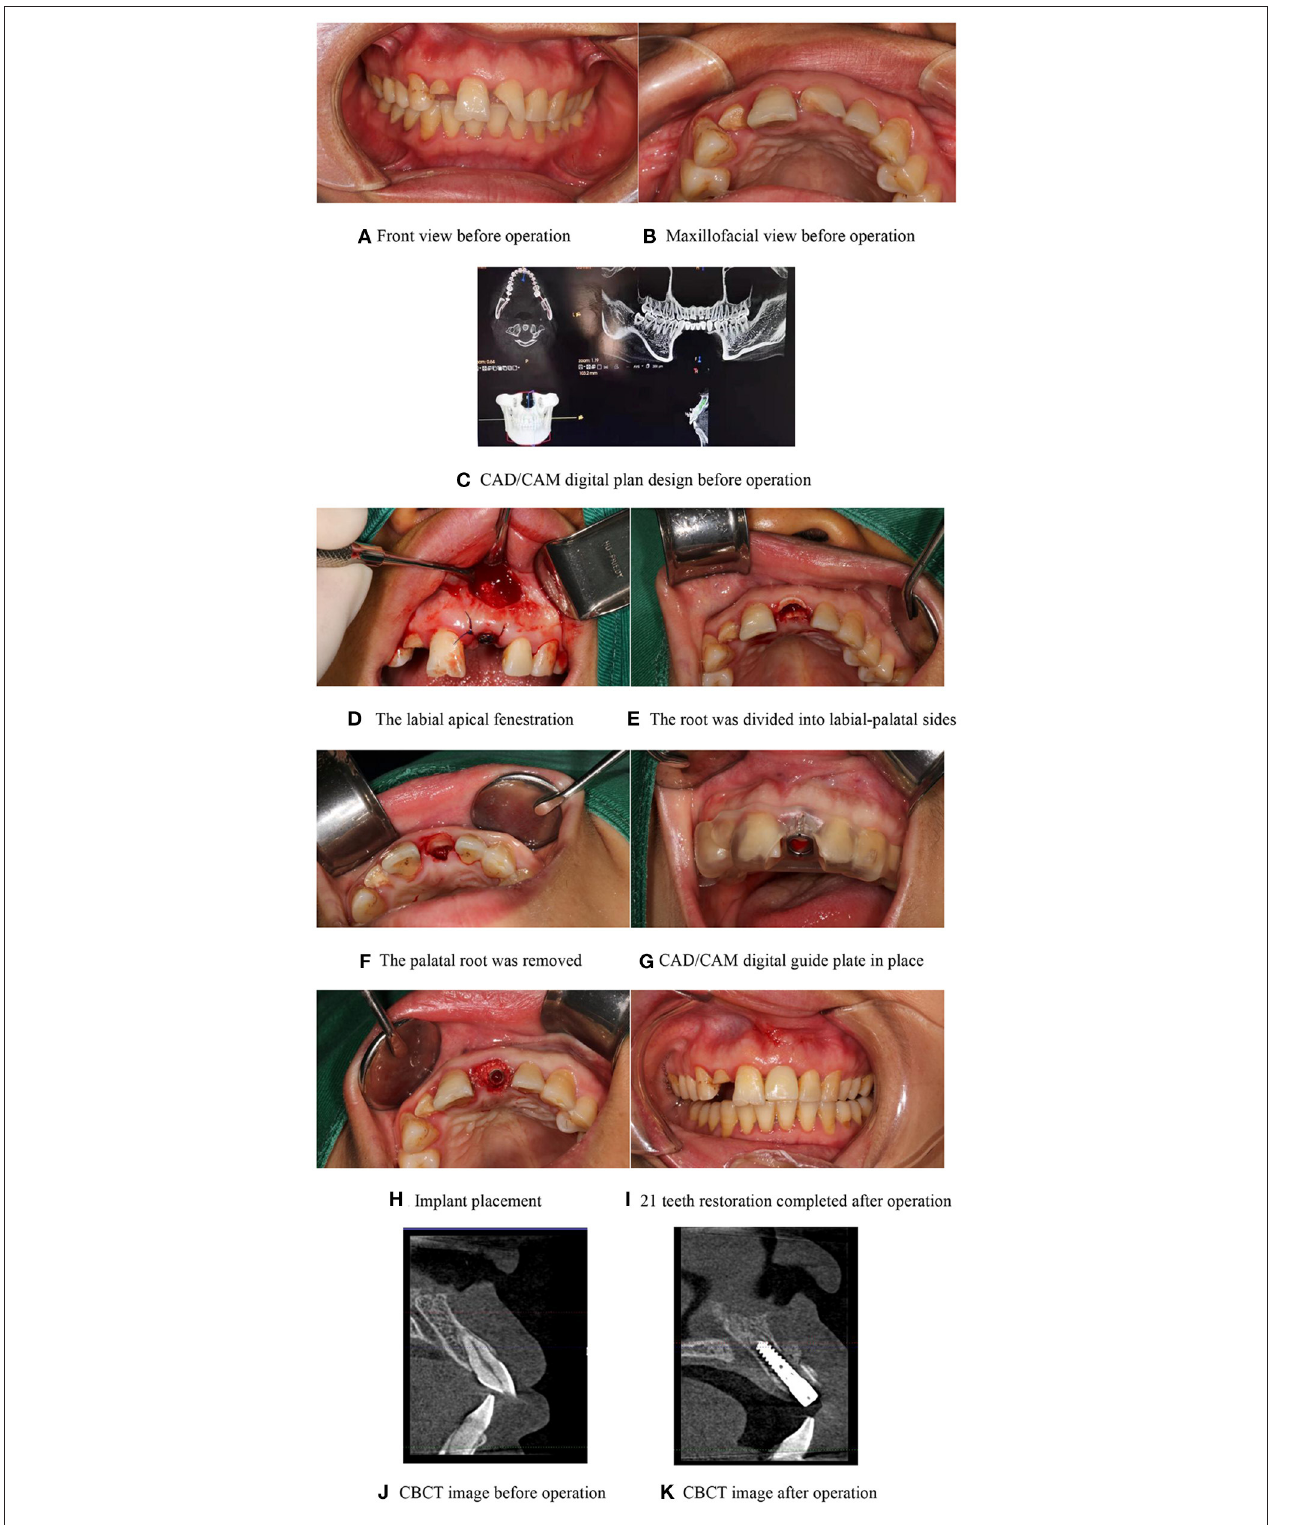
FIGURE 6 | Typical cases. (A) Front view before operation, (B) Maxillofacial view before operation, (C) CAD/CAM digital plan design before operation, (D) The labial apical fenestration, (E) The root was divided into labial-palatal sides, (F) The palatal root was removed, (G) CAD/CAM digital guide plate in place, (H) Implant placement, (I) 21 teeth restoration completed after operation, (J) CBCT image before operation, and (K) CBCT image after operation.